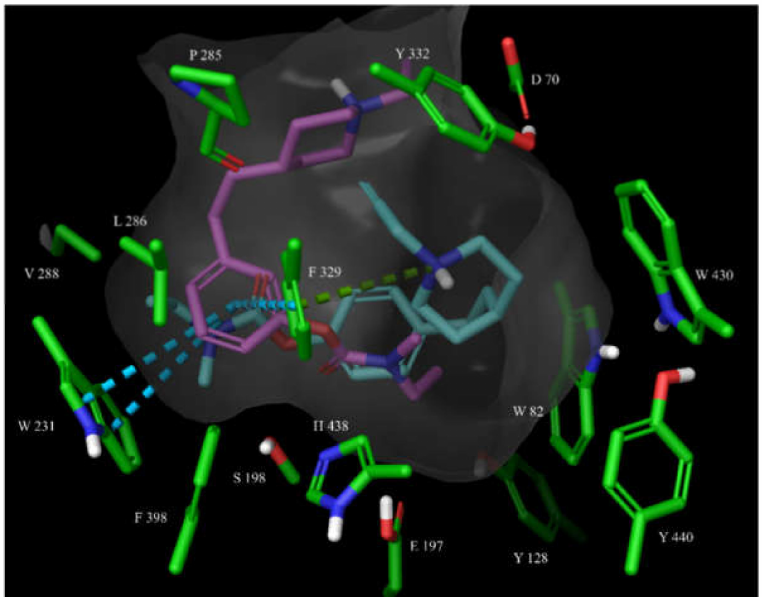
Figure 8. The overlay of docked 14 and 15 (shown as magenta and teal sticks, respectively) in the hBChE active site. The active site is shown as surface with the relevant amino acid residues shown as green sticks. The π - π interactions (shown as blue dashed lines) of 15 with Trp231 and Phe329 are a prerequisite for a successful covalent bond formation, as we have noticed in another series of carbamate hBChE inhibitors (unpublished